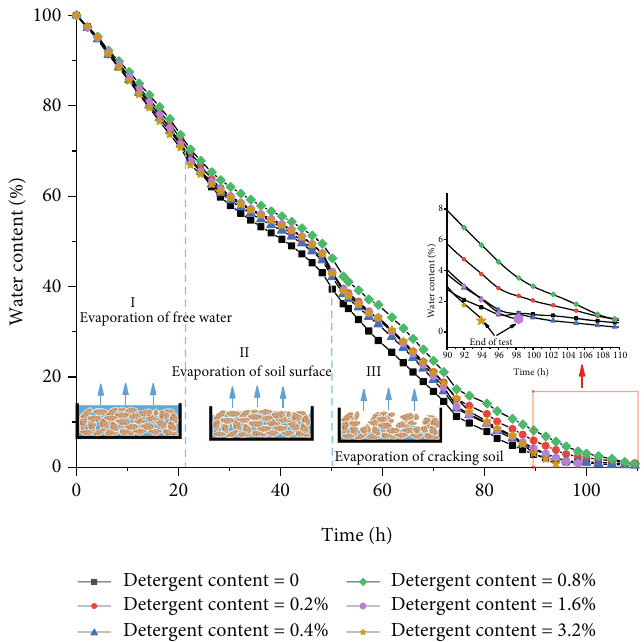
Figure 6: Changes in average water content with time.